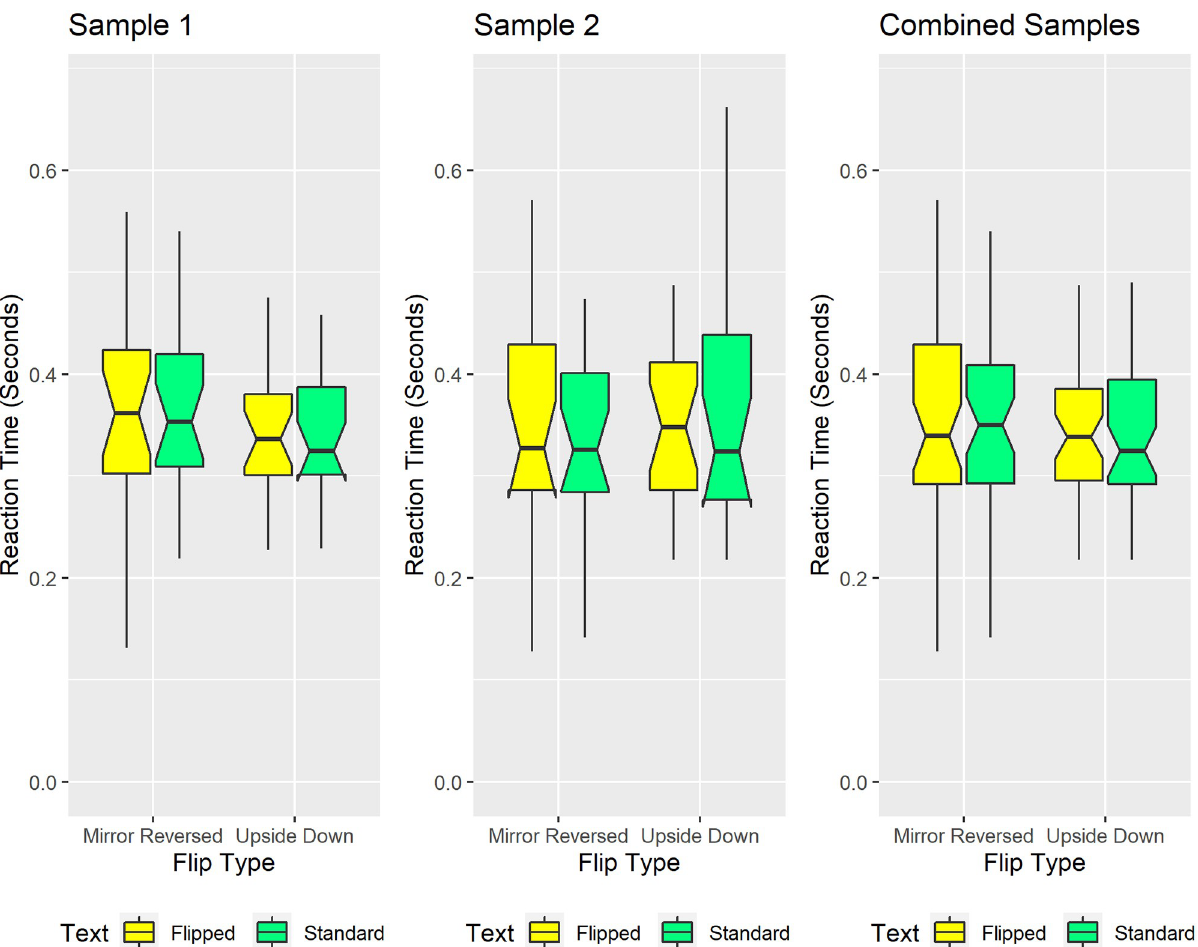
Fig 6. Reaction Times for sentence length judgments. Participants responded with comparable speed across conditions. Conventions remain the same as in Fig 5. Some of the colored boxes show downward-pointing protrusions. These reflect distributions skewed such that the 25th percentile falls within the median’s 95% confidence interval, i.e., within the box’s notched region [98, 99].